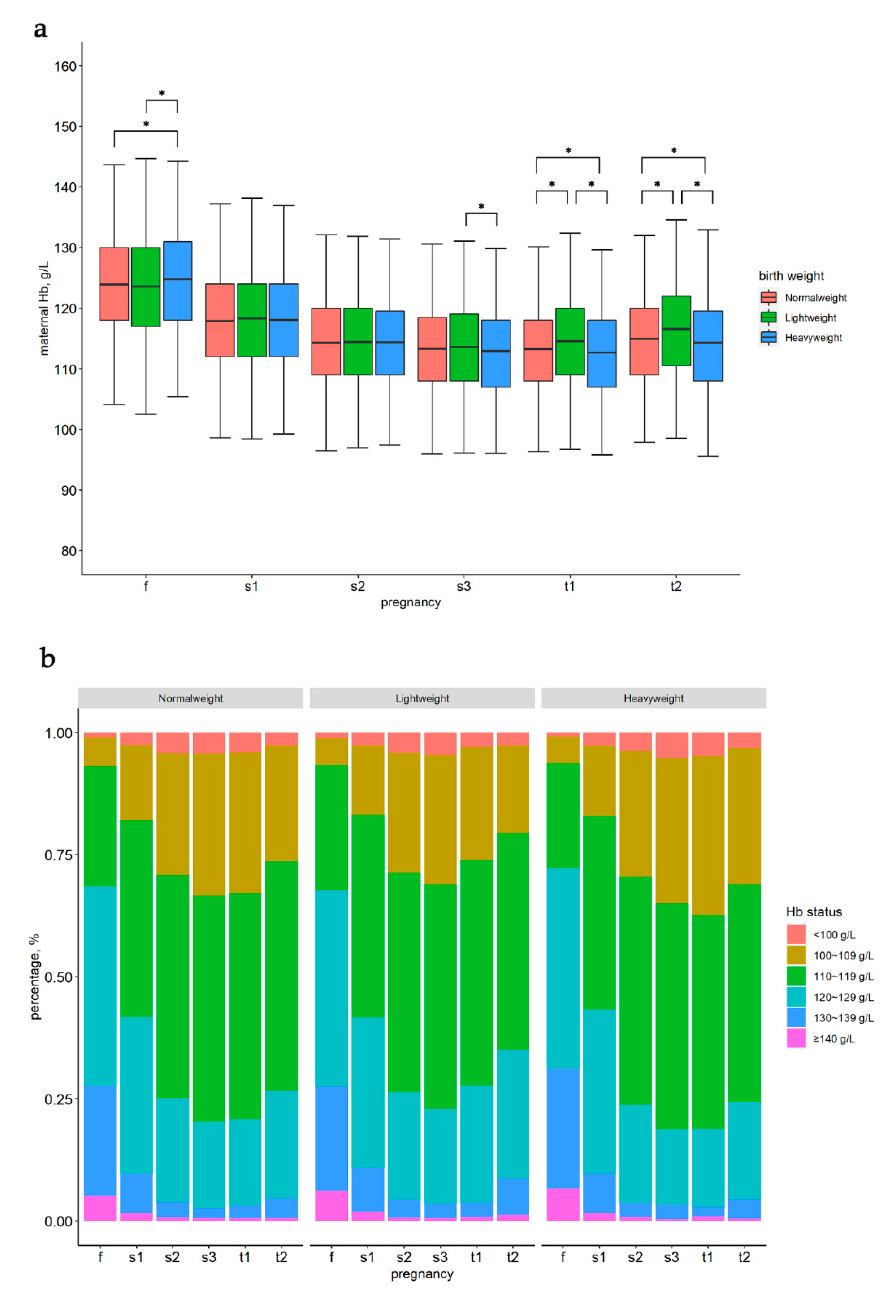
Figure 1. Maternal hemoglobin concentration ( a ) and percentage of maternal hemoglobin status ( b ) stratified by birth weight outcomes at different pregnancy time points. f, first trimester; s1, early- second trimester; s2, mediate-second trimester; s3, late-second trimester; t1, early-third trimester; t2, late-third trimester; * significant difference between the groups.